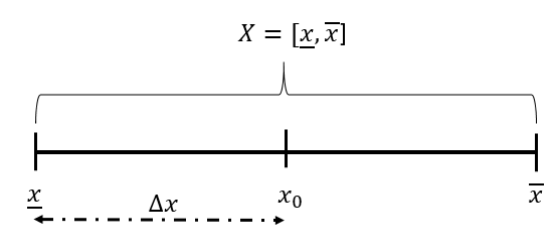
Figure 1. Interval X with upper bound ¯ x , lower bound x , central value x 0 and radius ∆ x